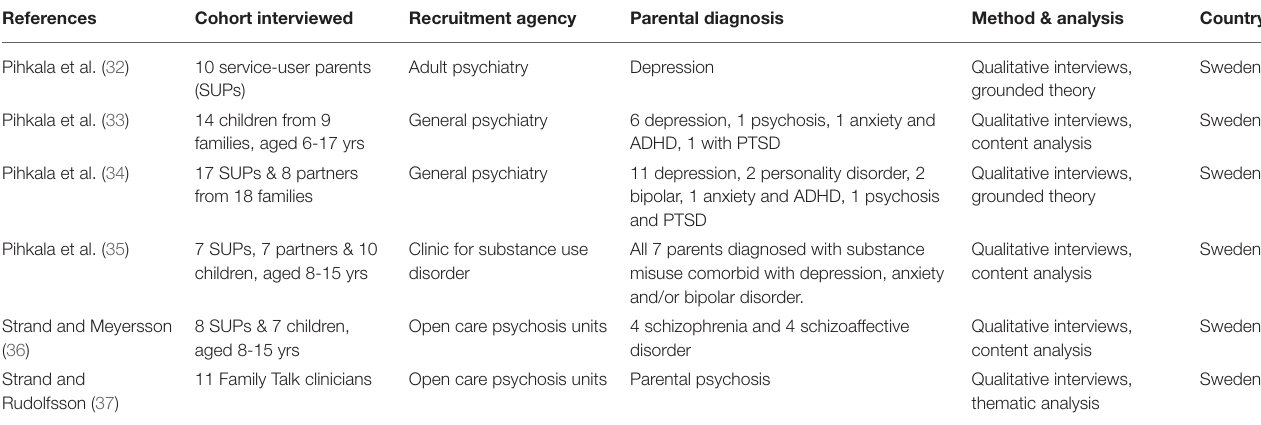
TABLE 1 | Qualitative studies of Family